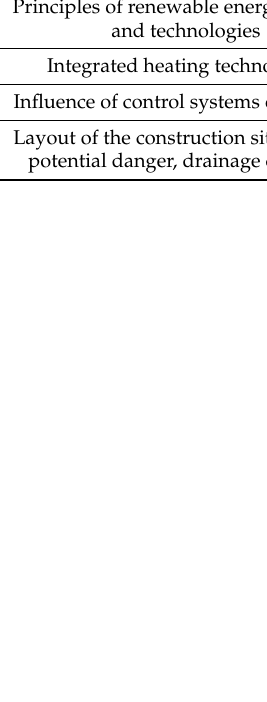
Table 3. Competency profiles of construction industry employees for Poland and Czech